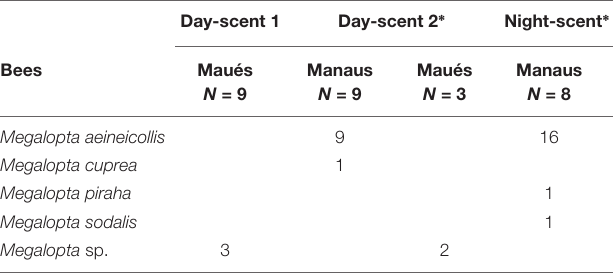
TABLE 2 | Number of Megalopta individuals attracted to different scent mixtures in field bioassays performed in Manaus and